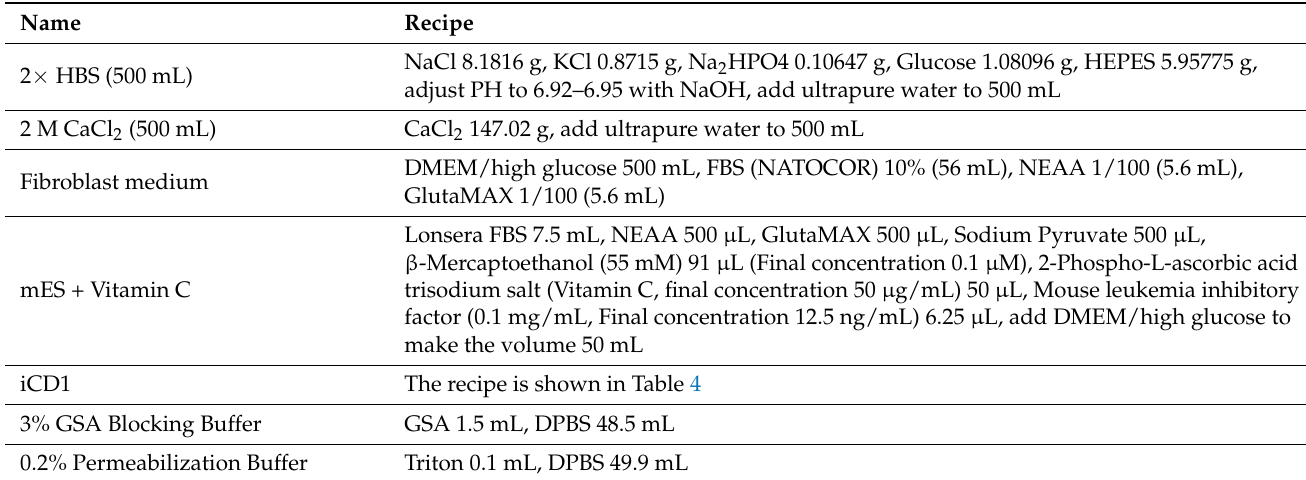
Table 3. Detailed information on the media and solution formula.